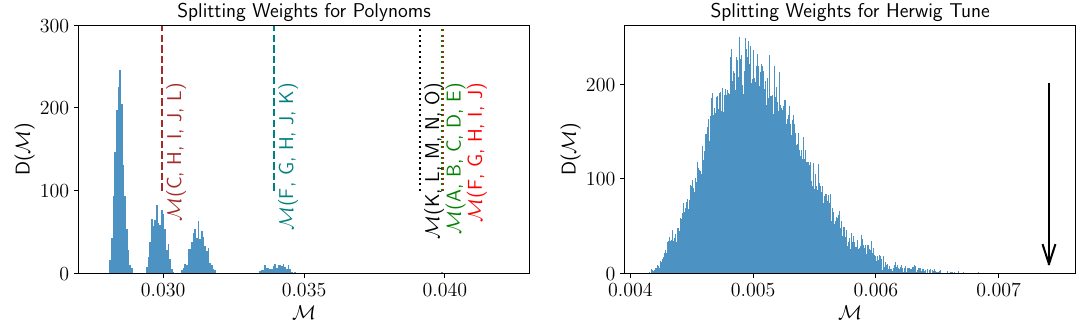
Fig. 2 Example of tune results for the α S ( M Z ) value with three iter- ations from left to right. The points are Goodness of fit (G.o.F.) values givenbyProfessorforvarious runcombinations (seeSects.3.3and 3.4 for details). While the old parameter ranges are given by dashed red lines, the 80% of the best G.o.F. values (blue points) determine the new green ranges for the next iteration. The 20% of the worst G.o.F. values